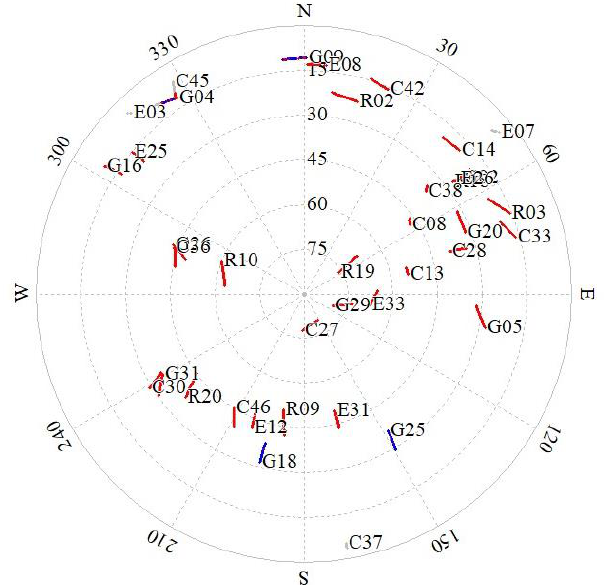
Figure 9 . The sky plot of the observed satellites for the kinematic car-borne experiment.